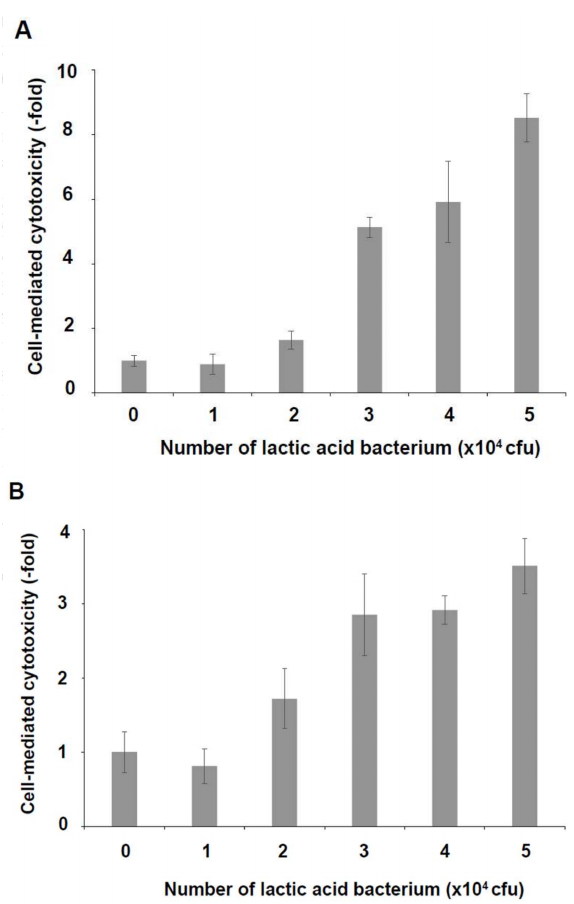
Figure 3. Induction of cell-mediated cytotoxicity by a six lactic acid bacteria mixture. KHYG-1 cells were treated with a six lactic acid bacteria mixture for 24 h at 37 ◦ C in a 5% CO 2 incubator. The treated cells were reacted with K562 cells ( A ) or with HCT116 cells ( B ) for 4 h at 37 ◦ C in a 5% CO 2 incubator. In both cases, cell-mediated cytotoxicity was increased by KHYG-1 cells that had been treated with the six lactic acid bacteria mixture in a dose-dependent